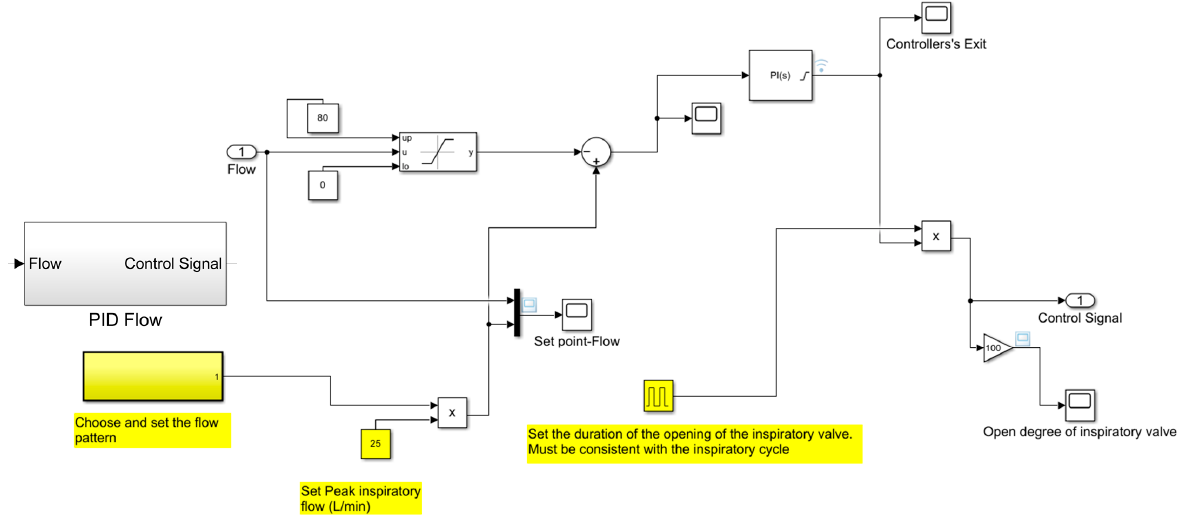
Figure 16. Subroutine reproducing the automatic control of the inspiratory flow.